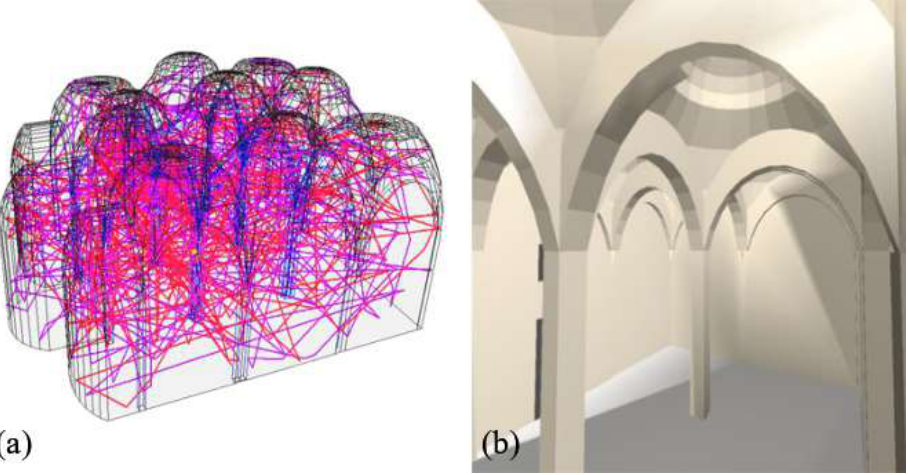
Figure 7. Hallaç Church ( a ) ray tracing model with source (red) and receiver (blue) positions; ( b ) 3D Open GL of an interior view.